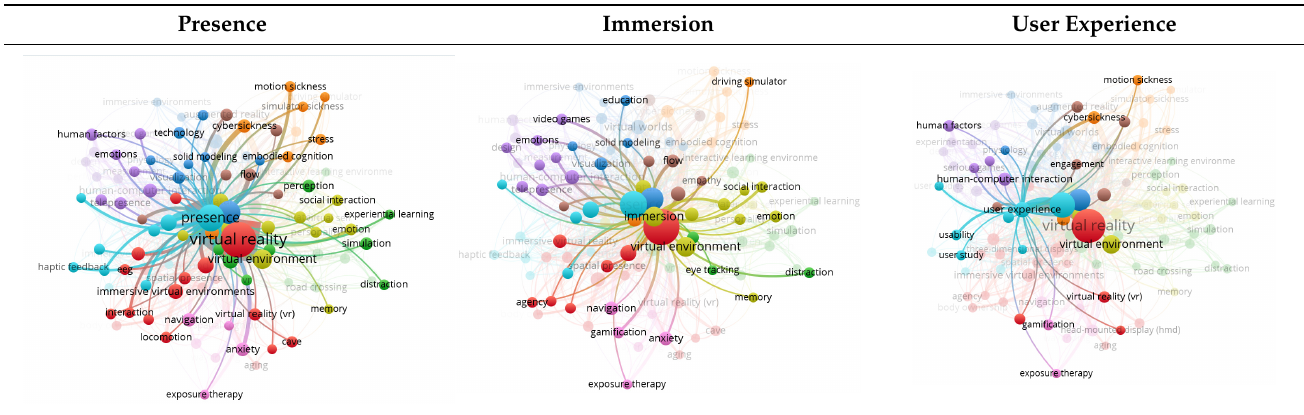
Table 13. Embodiment integrated experience in VEs.